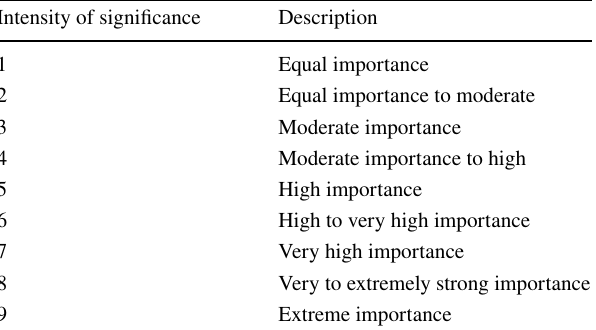
Table 7 Recommended scale of comparison Intensity of significance